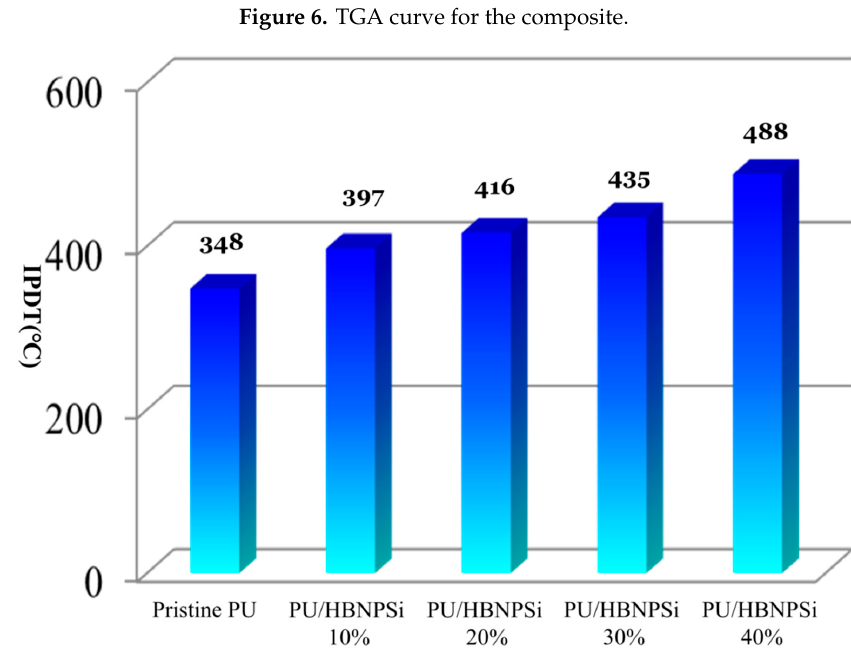
Figure 7. The IPDT data of pristine PU and PU/HBNPSi hybrid.